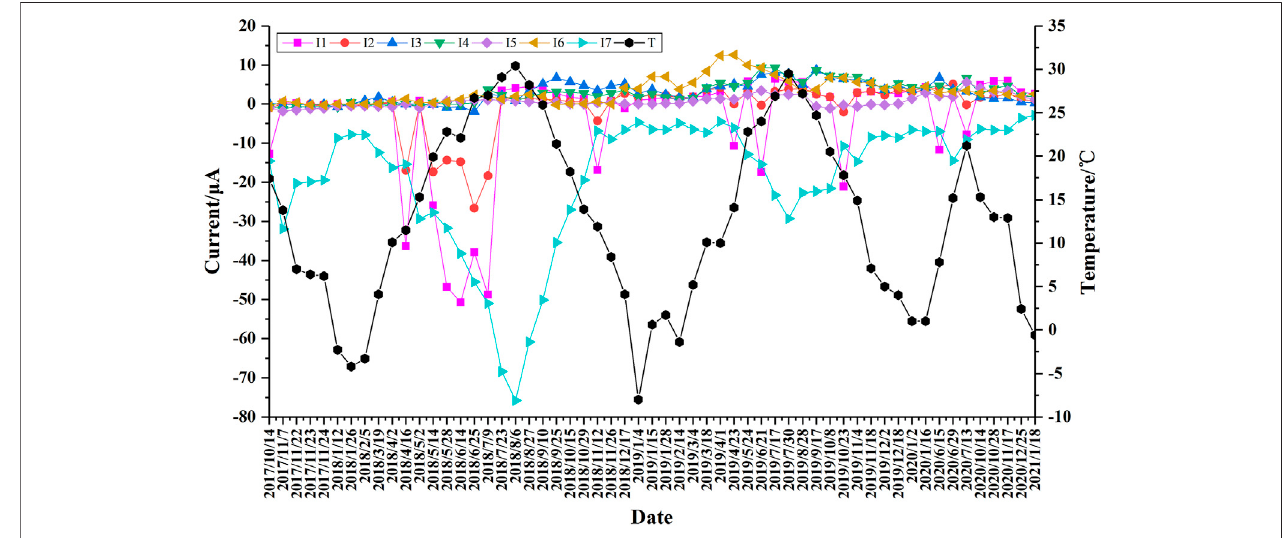
FIGURE 6 | Current between anode and cathode.